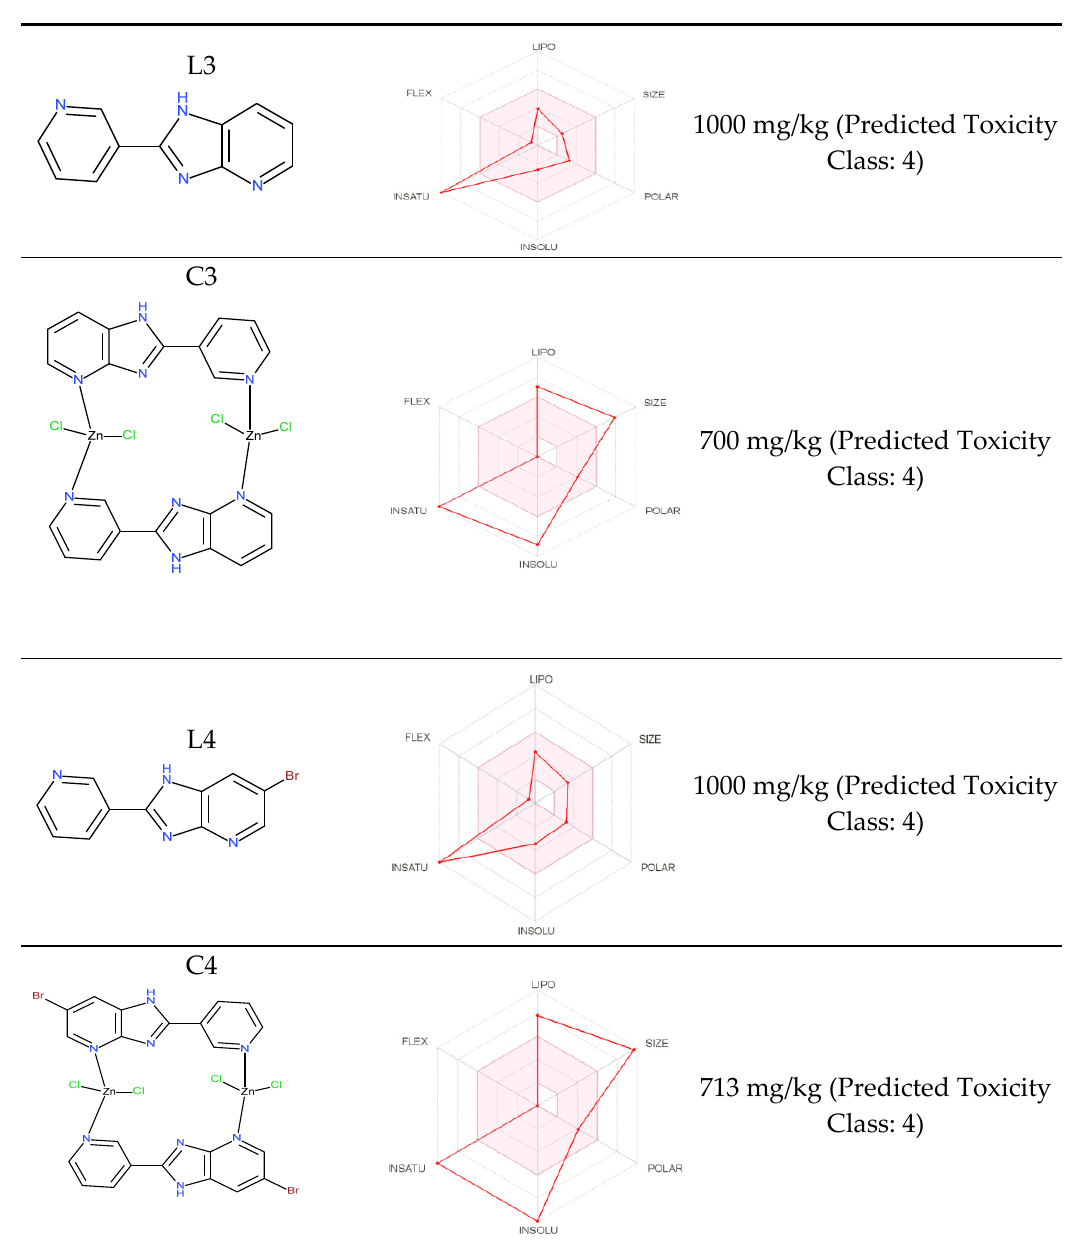
Figure 7. Bioavailability radars for complexes. Table 8. Cancer cell line prediction results for the ligand—Pa (probability “to be active”), Pi (probability “to be inactive”).